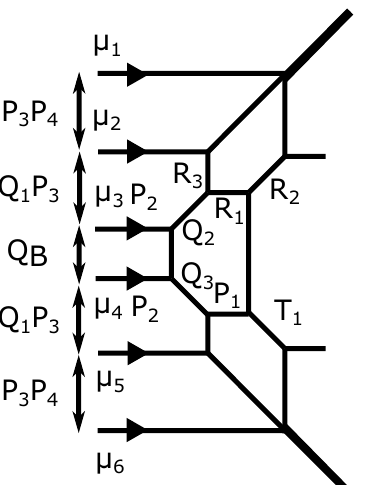
Figure 36. A parametrization of the web which is obtained after applying the 5d limit to the diagram in figure